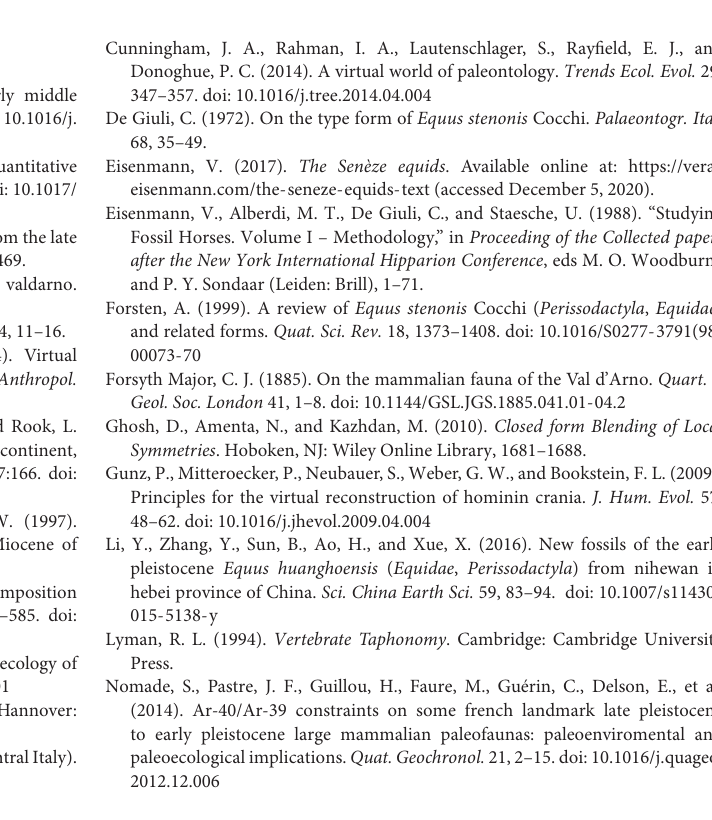
FIGURE S1 | IGF560R-S (A) and IGF560W-S (B) comparison by meshdist() ; color gradient (from blue to red) indicates the increase in mesh vertex displacement in millimeters. FIGURE S2 | Principal component analysis loadings. TABLE S1 | List of the selected landmarks on Equus stenonis IGF560 3D model. TABLE S2 | Raw data used in the principal component